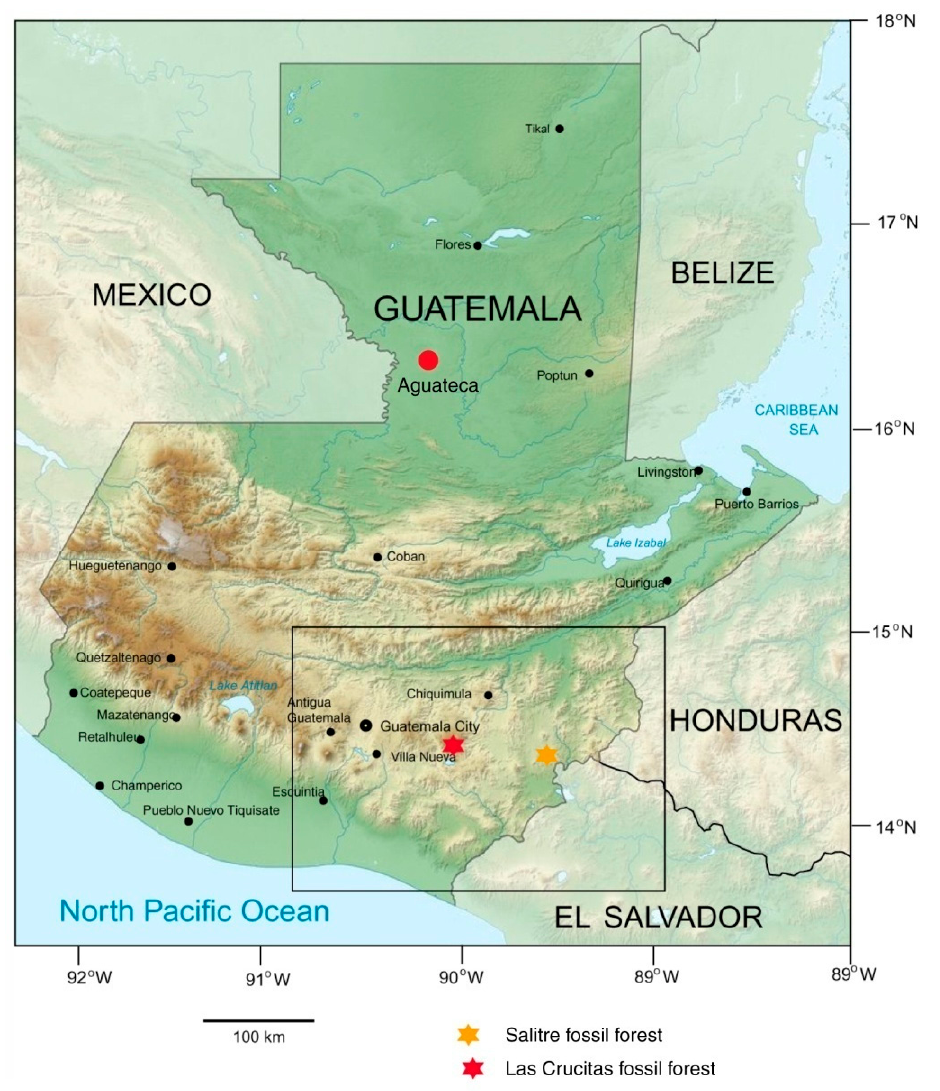
Figure 2. Location Map. The outlined area is the region shown in the map presented in the Geologic Setting Section.